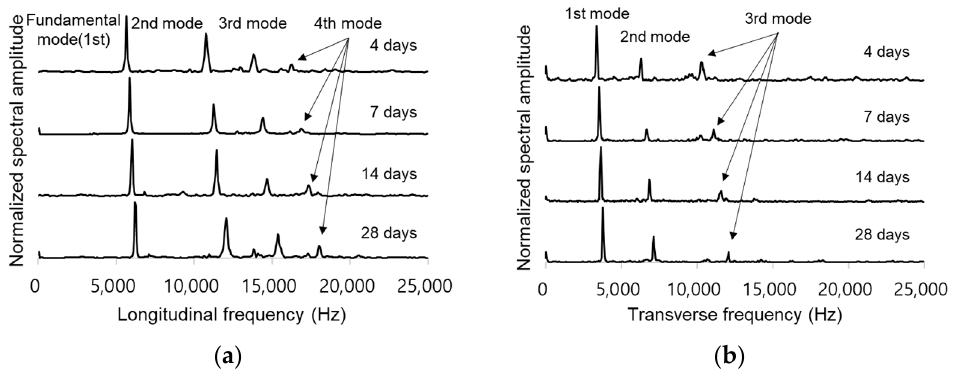
Figure 3. Resonance frequency by curing ages according to ASTM resonance test. ( a ) frequencies of longitudinal mode, ( b ) frequencies of transverse mode.